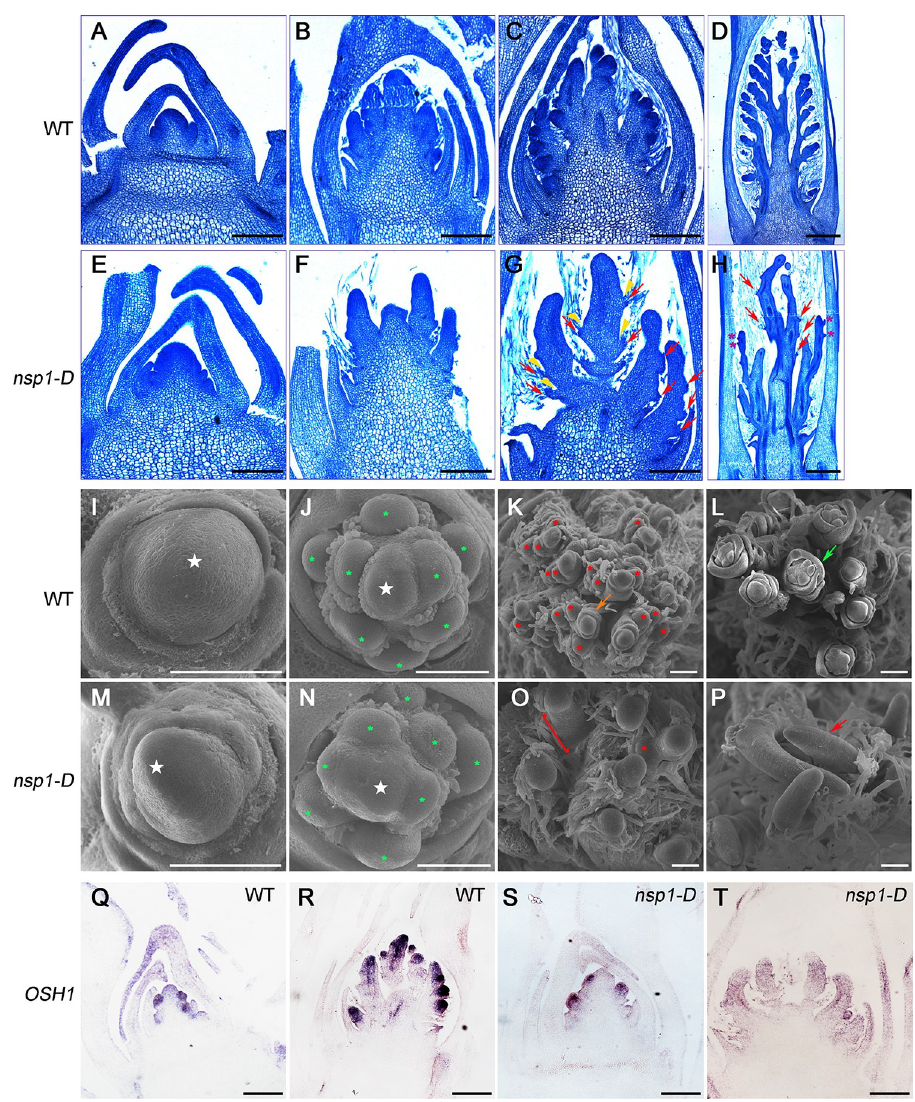
Fig 2. Morphological analysis of the nsp1-D . (A) to (H) Longitudinal section of a developing inflorescence in WT (A to D) and nsp1-D plants (E to H) during formation of the first bract primordium (A, E), the primary branch primordia (B, F), the secondary branch primordia or spikelet primordia (C, G), and the floret primordia (D, H). Red arrows (in G, H) indicate the empty bracts; Yellow arrowheads (in G) indicate the positions where the axillary meristems should initiate. Purple stars (in H) indicate the bract-like knobs. Bars = 200 μ m. (I) to (P) Scanning electron microscopy images showing the inflorescence development for WT (I to L) and nsp1-D plants (M to P) during formation of the first bract primordium (I, M), the primary branch primordia (J, N), the secondary branch primordia or spikelet primordia (K, O), and the floret primordia (L, P). White stars indicate inflorescence meristem; green and red asterisks denote primary and secondary branch primordia, respectively; the red bracket outlines the region where secondary branch primordia failed to initiate; the yellow, green, and red arrows denote spikelet primordia, floret primordia, and elongated primary branch primordia, respectively. Bars = 100 μ m. (Q) to (T) In situ localization of OSH1 in WT (Q, R) and nsp1-D (S, T) inflorescences at the stage of primary branch meristem (Q, S) and secondary branch meristem (R, T) differentiation. Bars = 100 μ